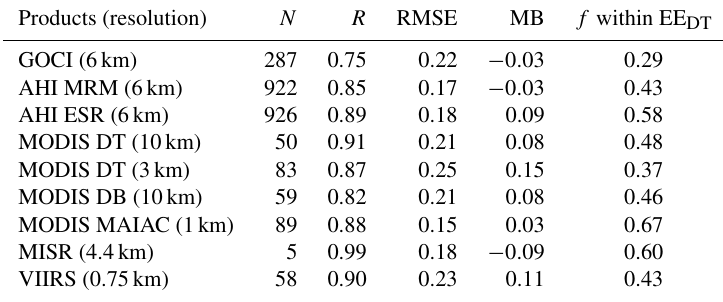
Table 4. Validation statistics for land AOD products using